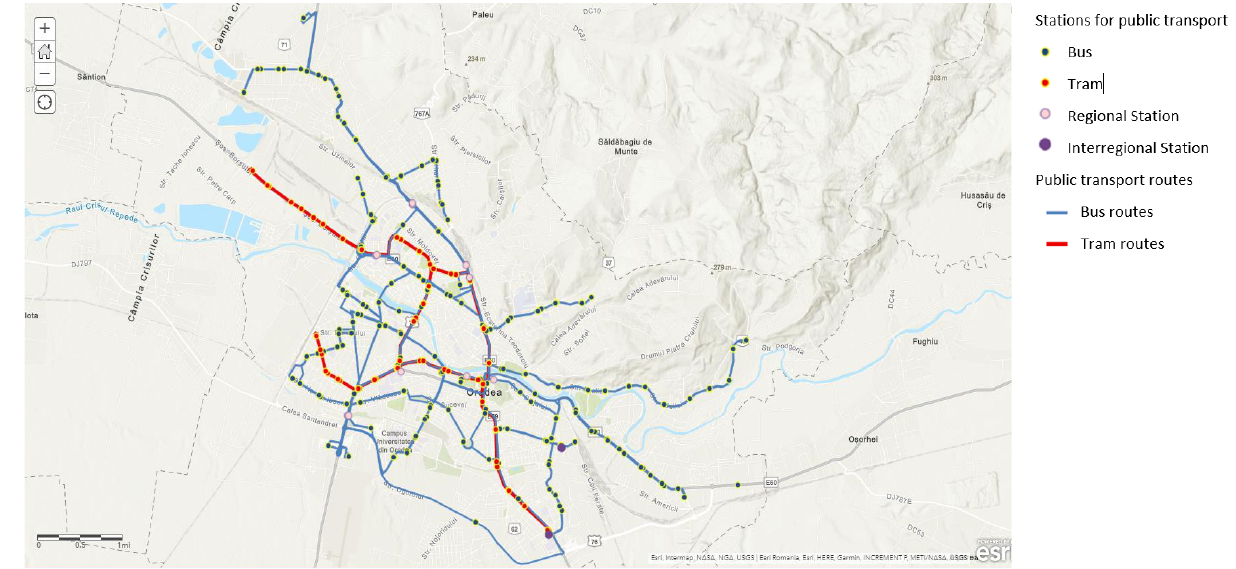
Figure 6. Public transport routes in Oradea, provided by O.T.L. (realized by the authors in ArcGIS